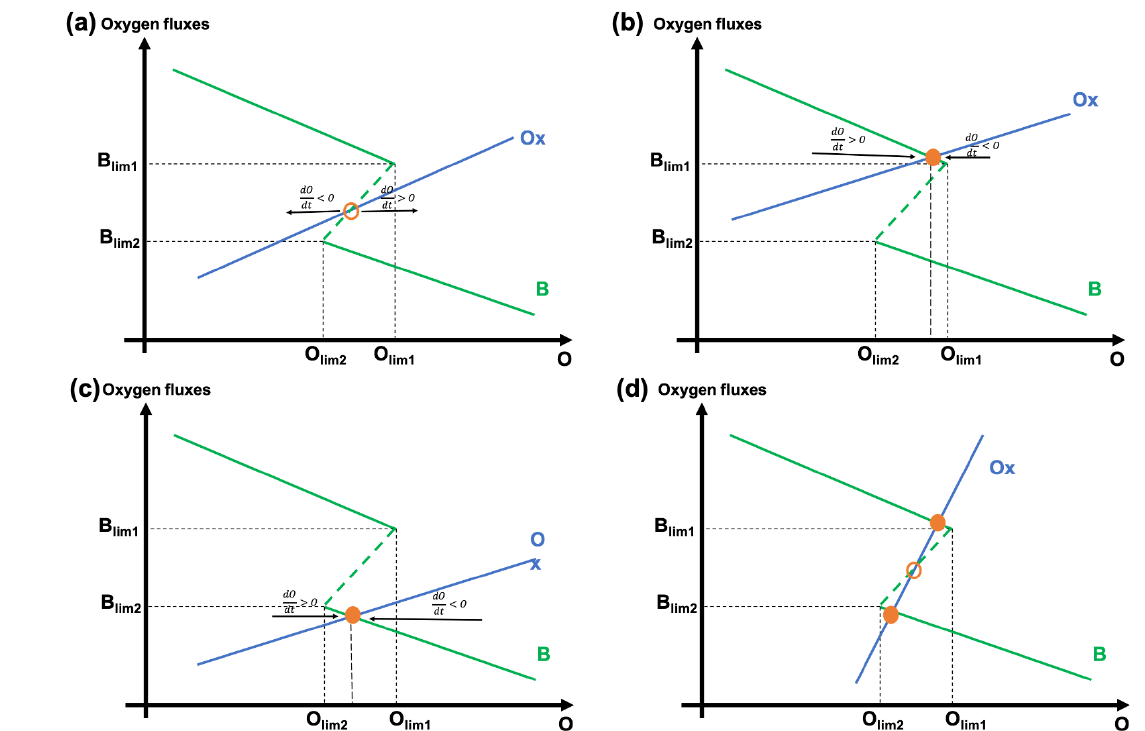
Figure 3. Schematic representation of the organic term (B, green curve) and the Redox term (blue curve) as a function of the oxygen content O. Four different cases are displayed, depending on the slope and intercept of the Redox curve: (a) one unstable equilibrium, (b) and (c)